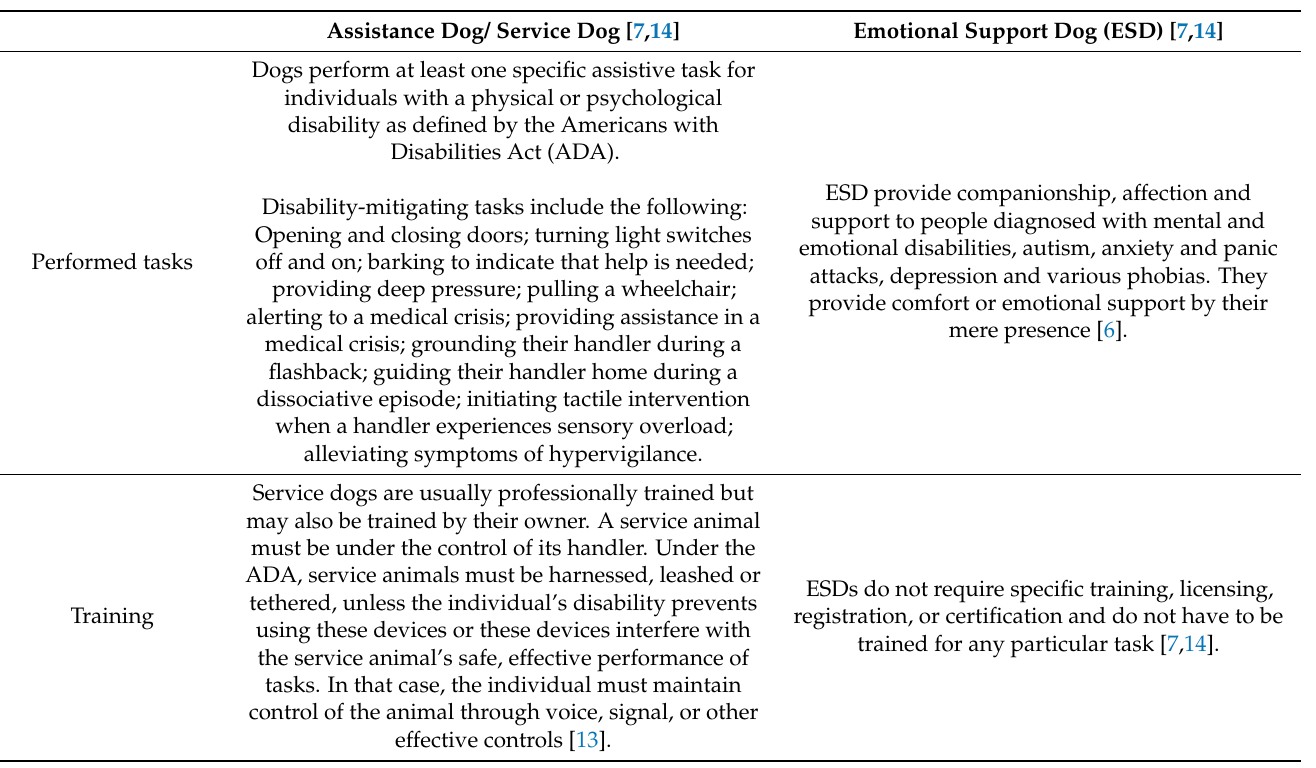
Table 2. Assistance Dogs and Emotional Support Dogs (ESD): Performed tasks and training. Assistance Dog/ Service Dog